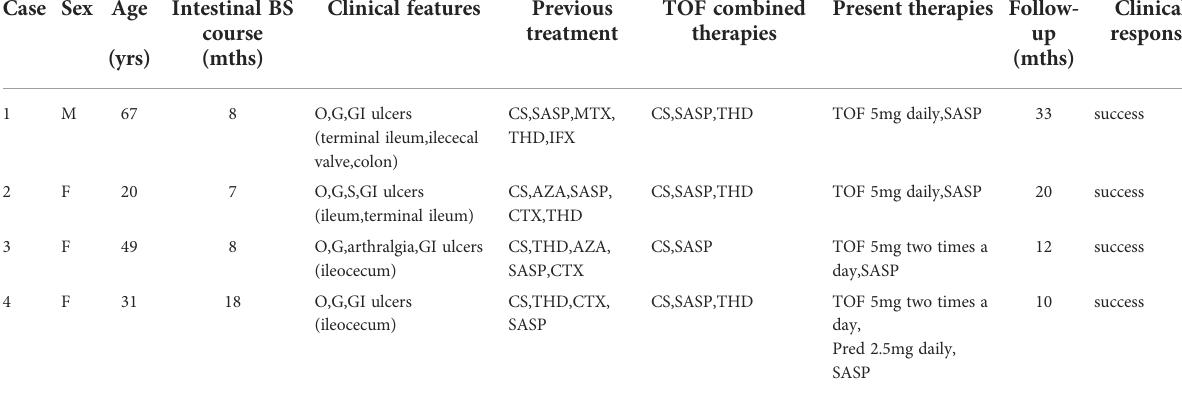
TABLE 1 Clinical characteristics and therapeutic interventions of refractory intestinal Behc ̧ et ’ s